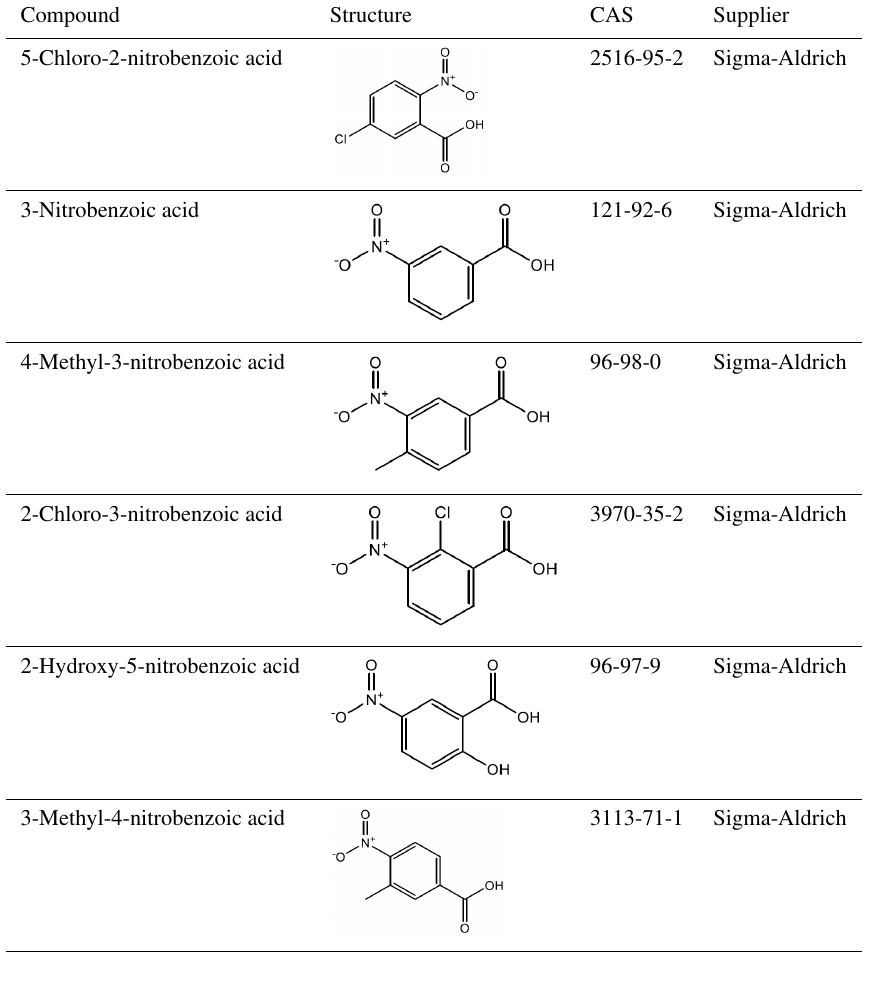
Table 3. Nitrobenzoic acids measured with the